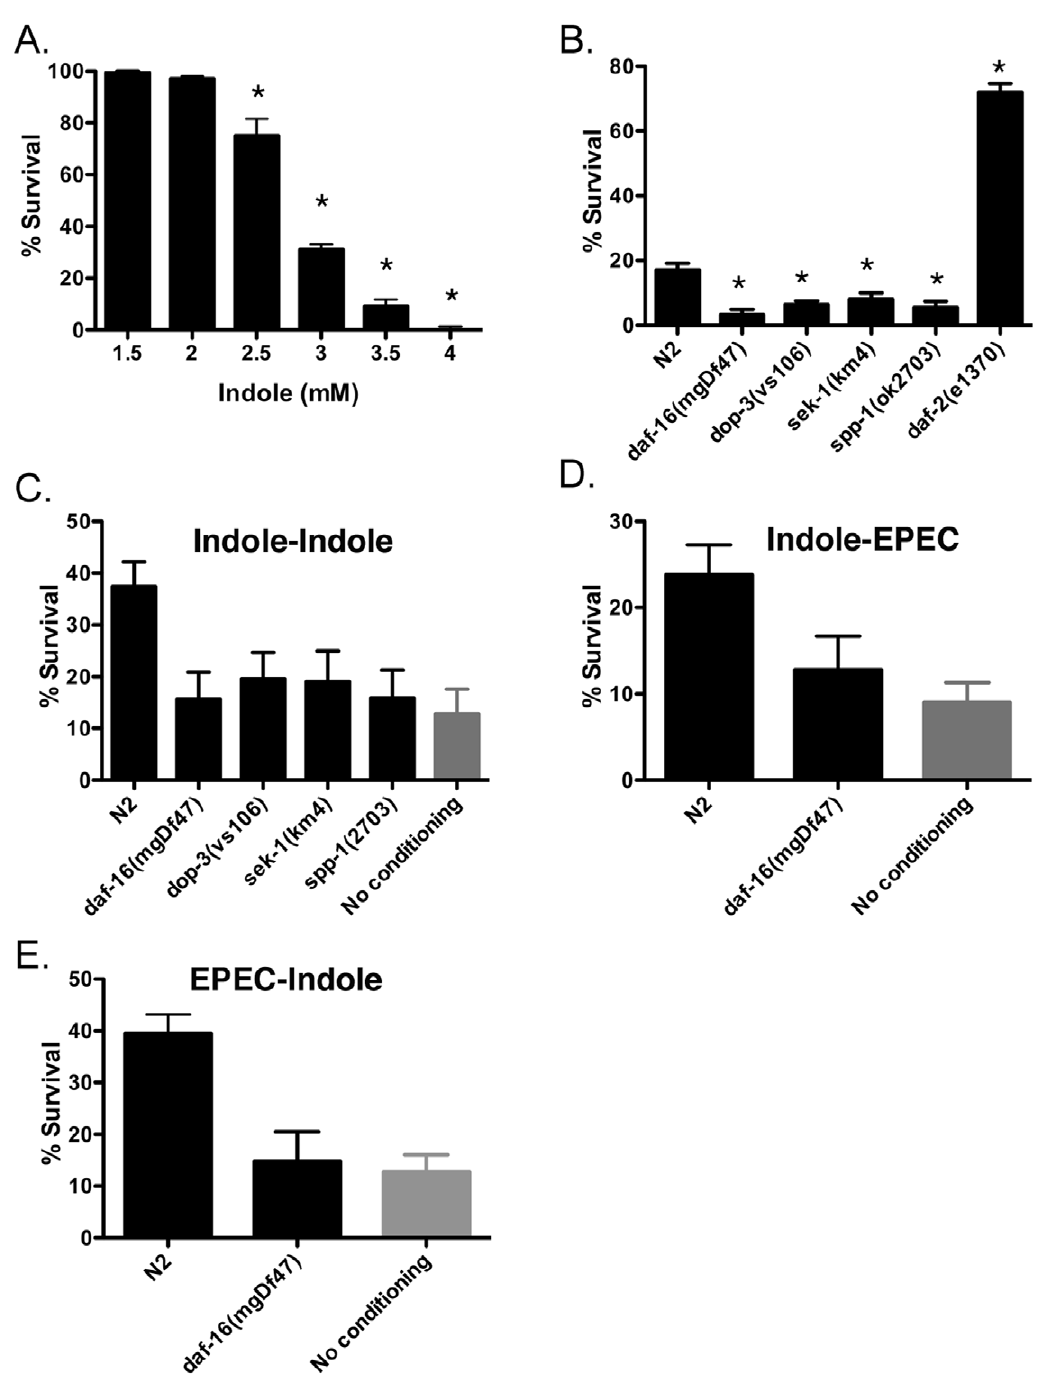
Figure 2. Effects of synthetic indole on C.elegans . ( a ) Effects on survival of C. elegans N2 upon exposure to various concentrations of synthetic indole in LB broth for 3 hours. ( b ) Effects on survival of C. elegans N2 and various mutants upon exposure to 3.5 mM synthetic indole in LB broth for 3 hours. In a-b, mean + / 2 SEM are shown; * corresponds to p , 0.01 with respect to controls (1.5 mM in A; N2 in b). ( c ) Effects of pre-exposure of N2 or various mutants to 3.5 mM indole for 15 minutes followed by a 3 hour waiting period on OP50, and then a 3 hour challenge with 3.5 mM indole. The grey bar indicates the percent survival without conditioning. ( d,e ) Effects of pre-exposure of N2 or daf-16(mgDF47) to indole (15 minutes) or to EPEC (30 minutes) followed by a 3 hour waiting period on OP50, and then a 3 hour challenge with either EPEC/LBT ( d ) or 3.5 mM indole ( e ). In both cases, only N2 was conditionable. In c-e, mean + / 2 95% confidence intervals are shown. Lack of overlapping error bars indicates significance at the 5% level. doi:10.1371/journal.pone.0054456.g002 Fig. 3a, the extract killed C. elegans at lower apparent concentra- Fig. 2a) with the LD 90 for the indole in the extract ( , 1.5 mM) tions of indole than were achieved with synthetic indole. revealed a 2.3-fold difference (Fig. 3a). Thus, the apparent Comparison of the LD 90 for synthetic indole ( , 3.50 mM; concentration of indole in the extract alone did not appear